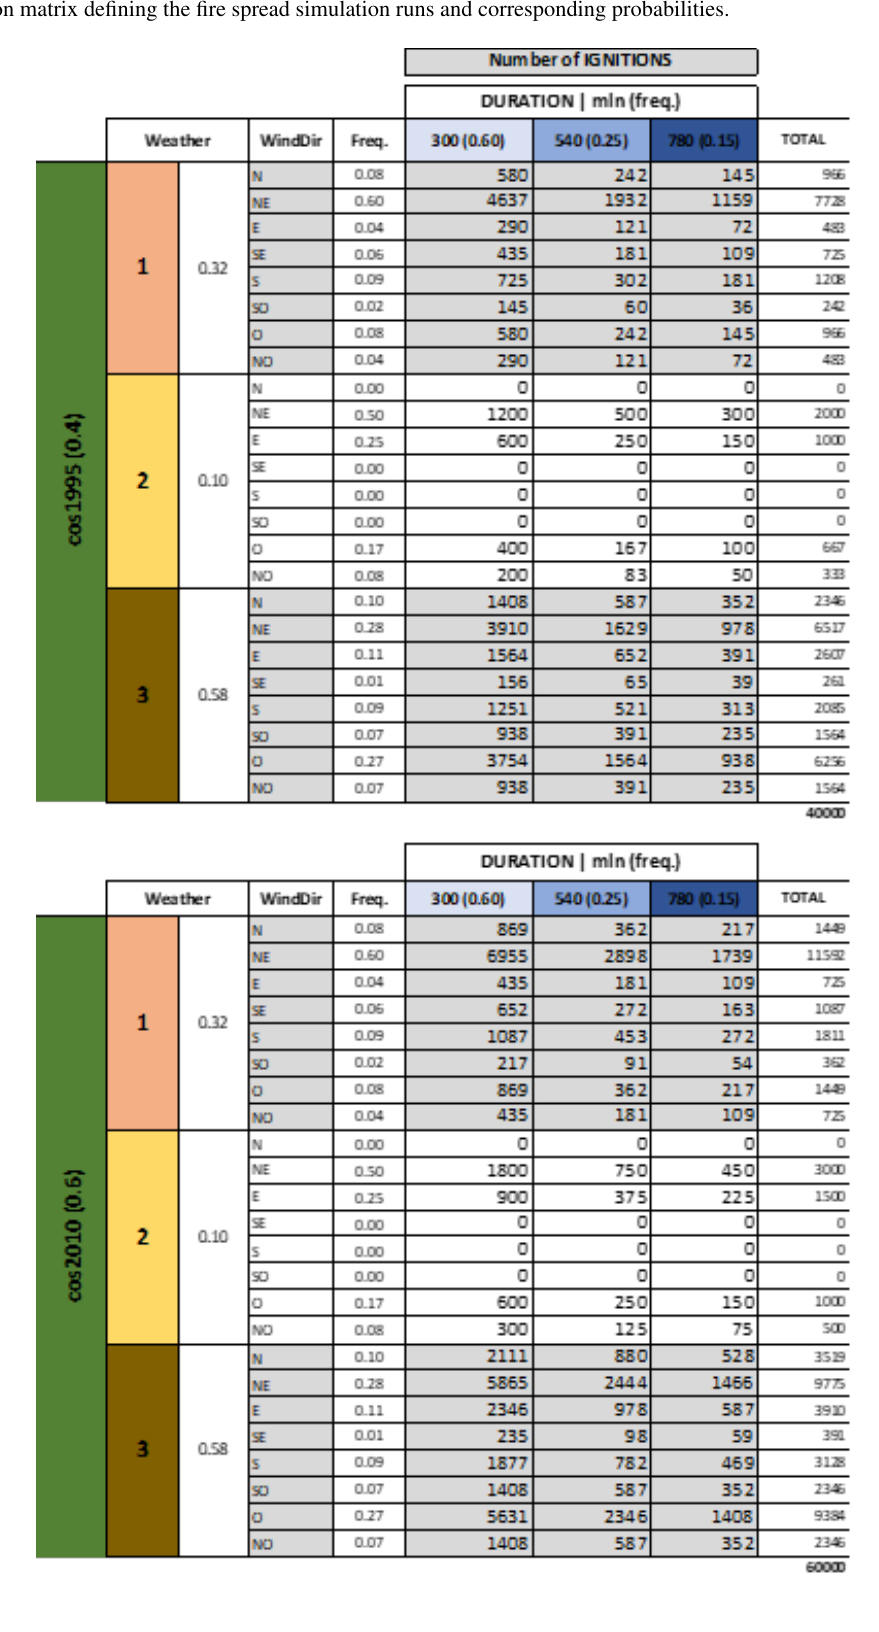
Table C1. Calibration matrix defining the fire spread simulation runs and corresponding